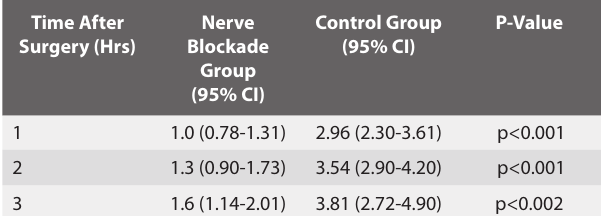
Table 4. Subgroup analysis of postoperative pain scores in septoplasty groups* Comparison of pain levels 1-3 hours postoperatively in nerve blockade intervention group with control